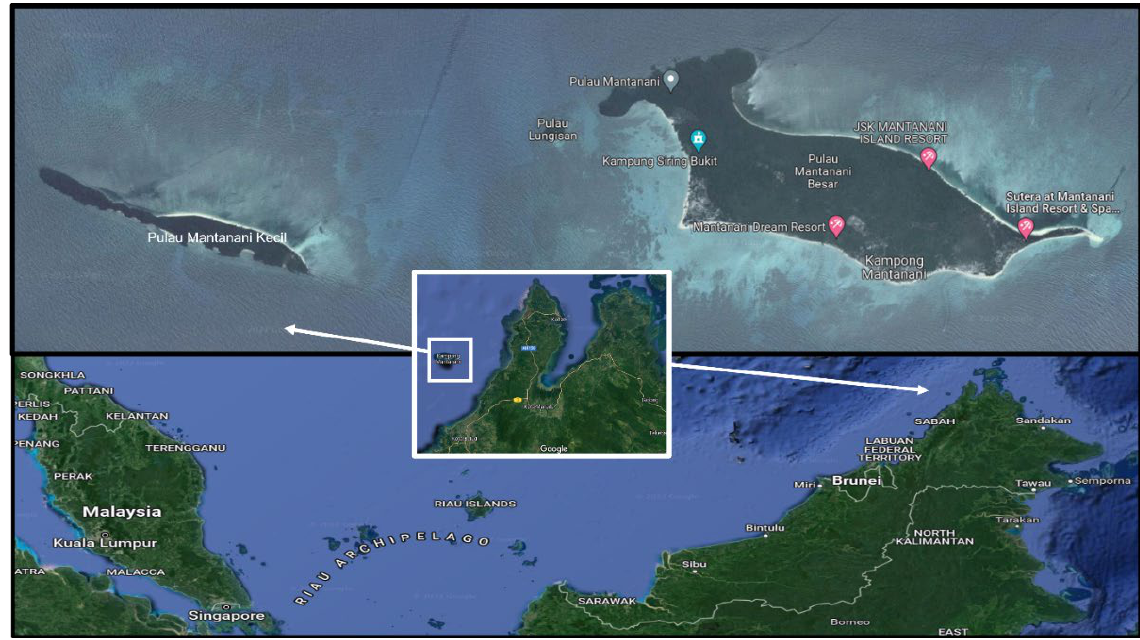
Figure 3. Location Map of Mantanani Island in the Northern Part of Sabah.